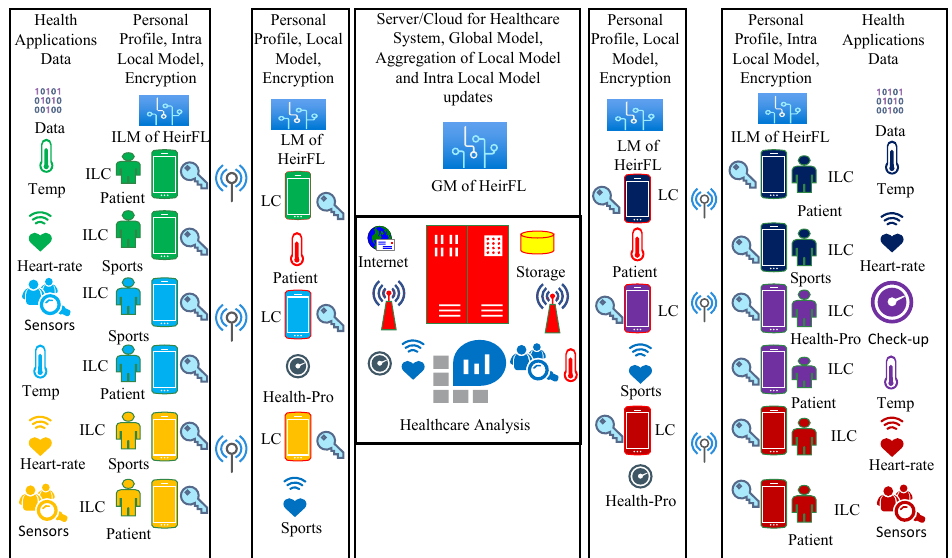
Figure 1. The proposed secure hierarchical federated learning (SHFL) architecture. A realistic deployment of different healthcare application-aware IoT devices is assumed, in which the LC devices directly communicate with the healthcare cloud/server. All the assumed devices are based on modern IoT infrastructure that can run local learning models over the rich data generated by the healthcare